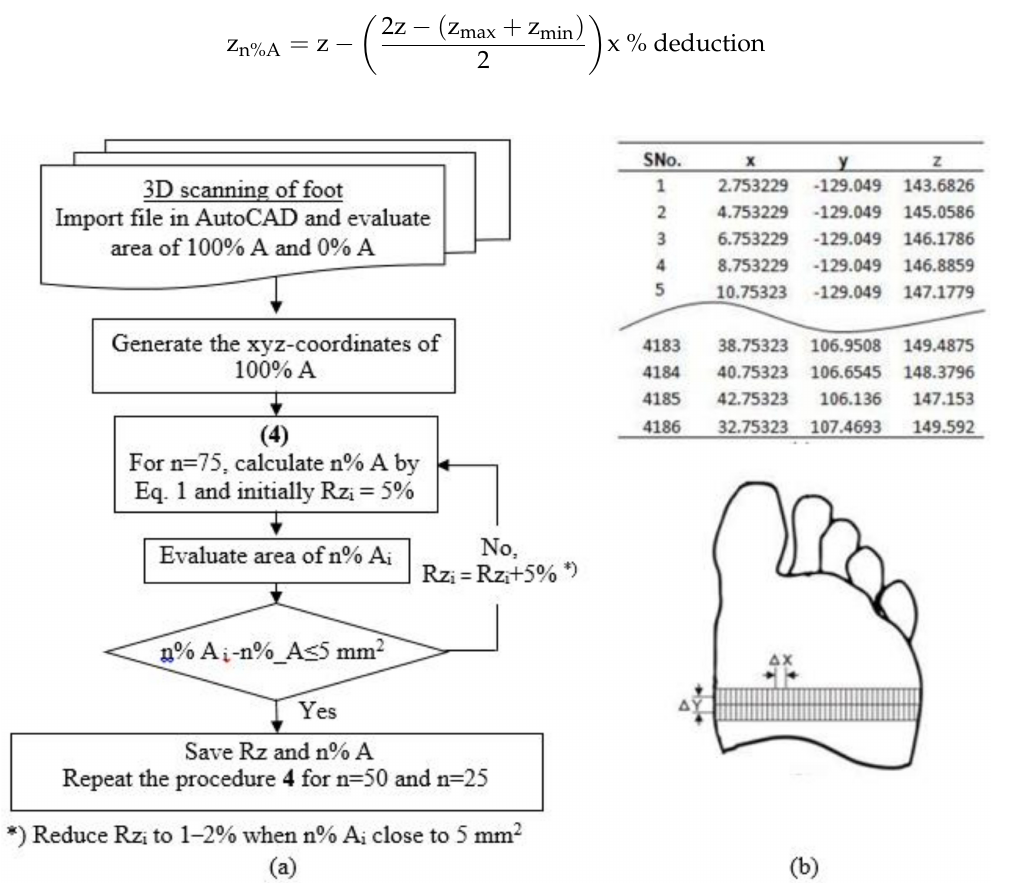
Figure 3. ( a ) Flowchart evaluation of n% insole foot area; ( b ) Table of 3D coordinates (x, y, and z axis) generated from AutoCAD with the visualization of the increment of x- and